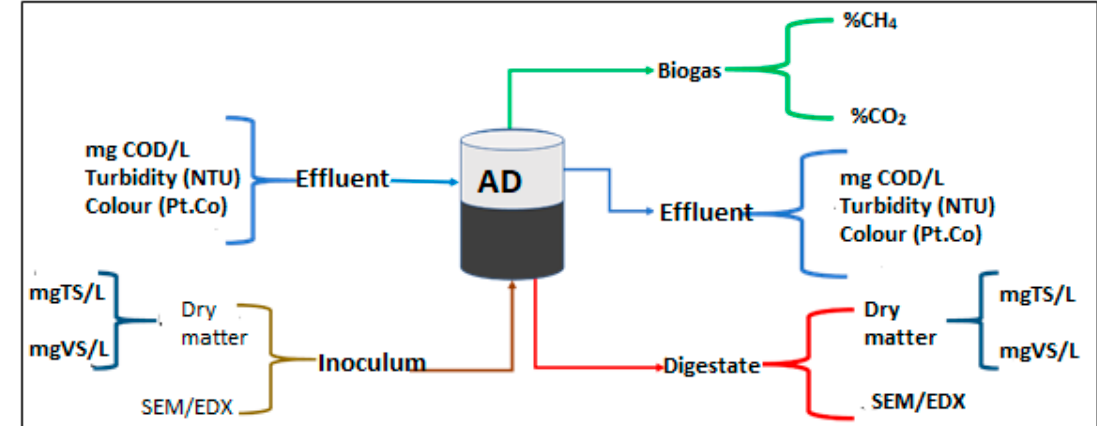
Figure 7 . Schematic diagram of the component balance of the digestate input and output analysis. Figure 7. Schematic diagram of the component balance of the digestate input and output